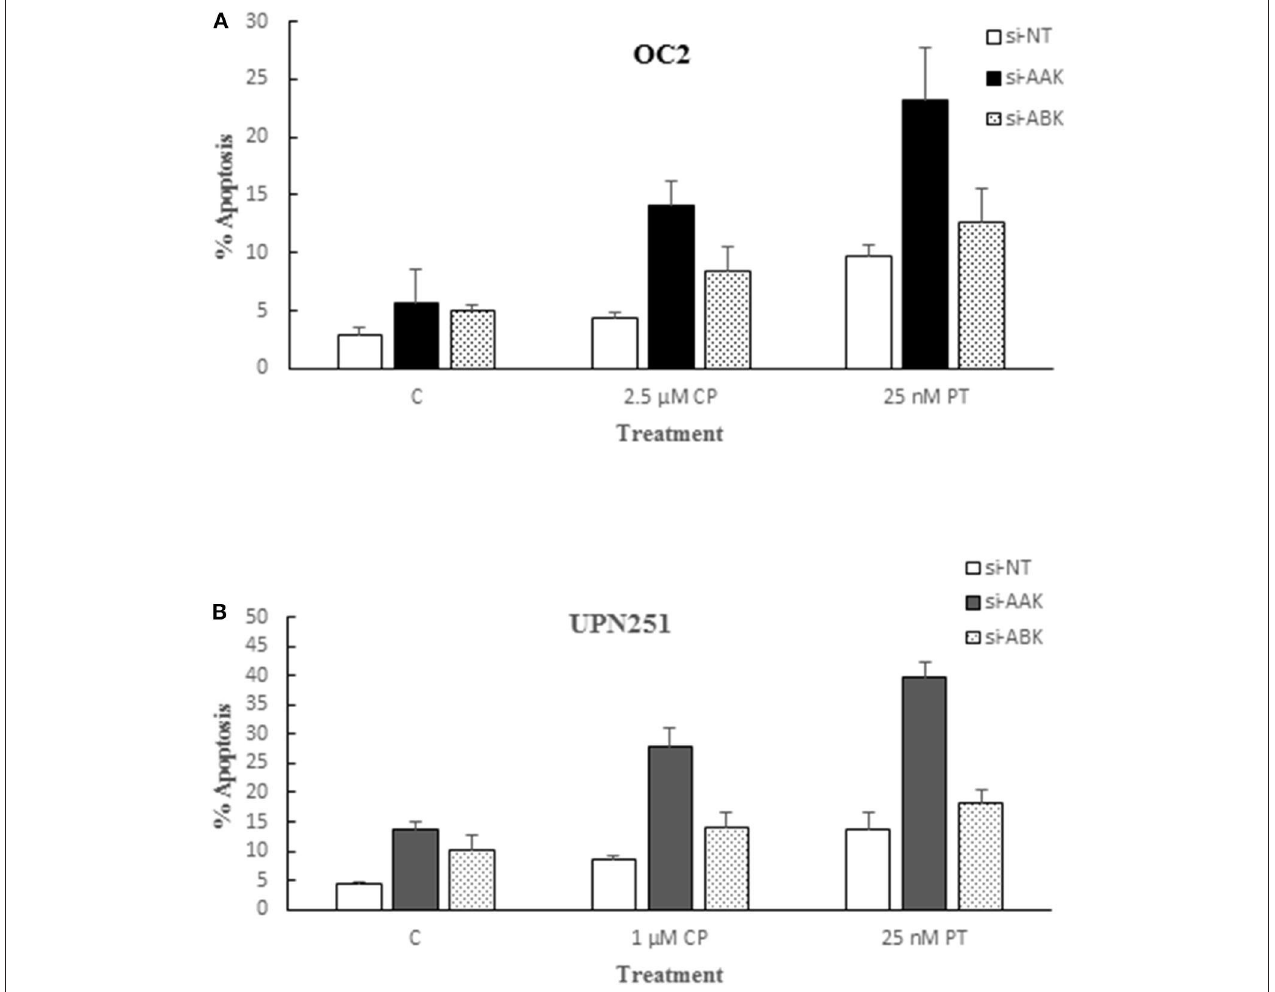
FIGURE 4 | Alisertib targets aurora A kinase for potentiation of cisplatin and paclitaxel induced apoptosis. OC2 (A) and UPN2561 (B) cells were treated with indicated concentrations of cisplatin for 3h or paclitaxel for 6h followed by removal of drug and transfection with a non-targeting siRNA (NT) or siRNA targeting AAK or ABK for 72h. Apoptosis at the end of siRNA exposure was determined as described earlier for Figure 2B . Data are mean ± standard deviation from at least triplicate experiments. siAAK compared to NT (OC2–CP 2.5-fold; PT 4.1-fold; UPN251- CP 2.0-fold; PT 2.9-fold) vs. siABK compared to NT (OC2–CP 1.7-fold; PT 2.5-fold; UPN251- CP 1.4-fold; PT